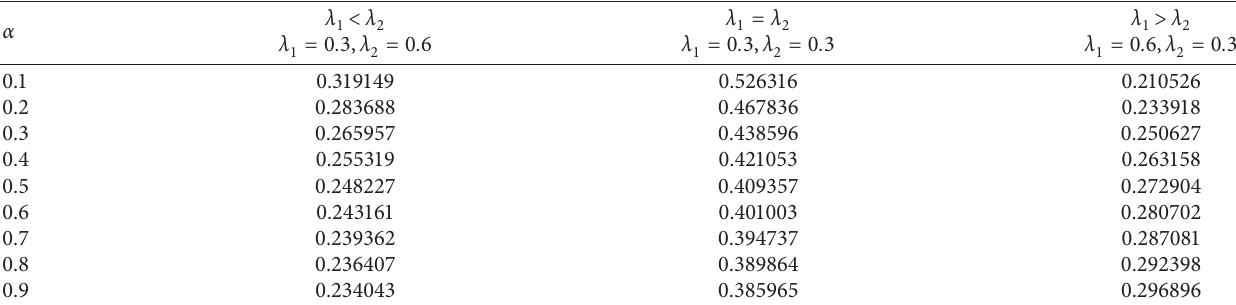
Table 3: The steady-state availability for different values of α when ( β � 0 . 6 , φ � 0 . 0 . 4 , μ 4 2